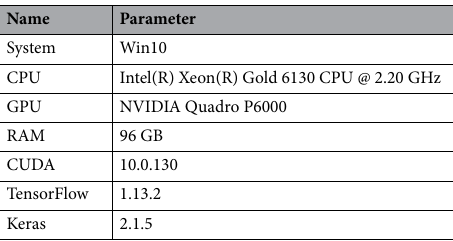
Table 4. Hardware and software configuration information.